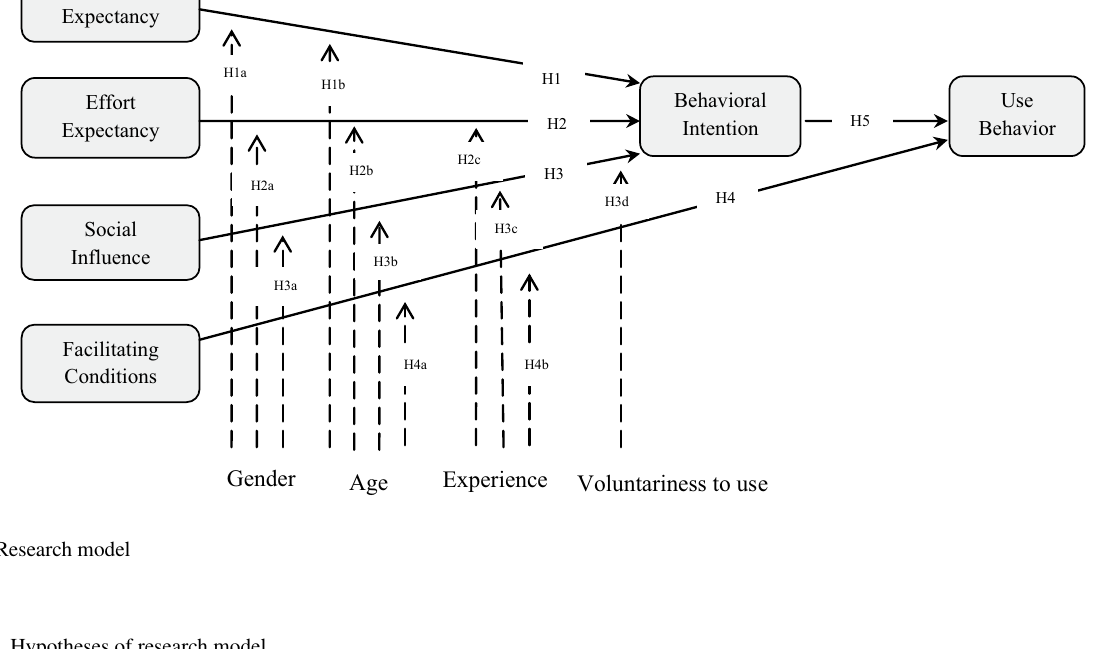
Table 1 Hypotheses of research model